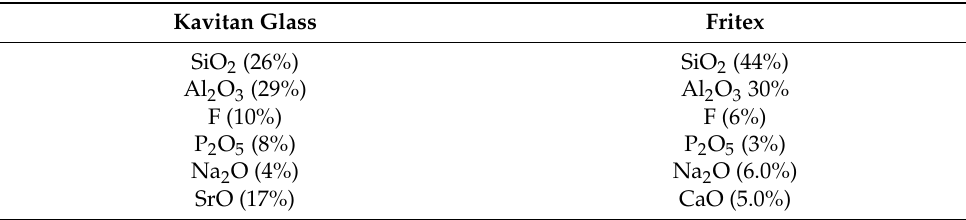
Table 1. Compositions of glasses used in polymethyl methacrylate (PMMA) modification.